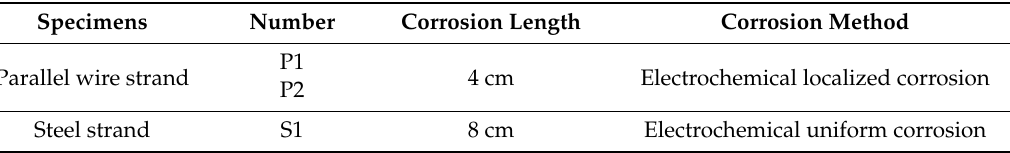
Table 2. The parameters of